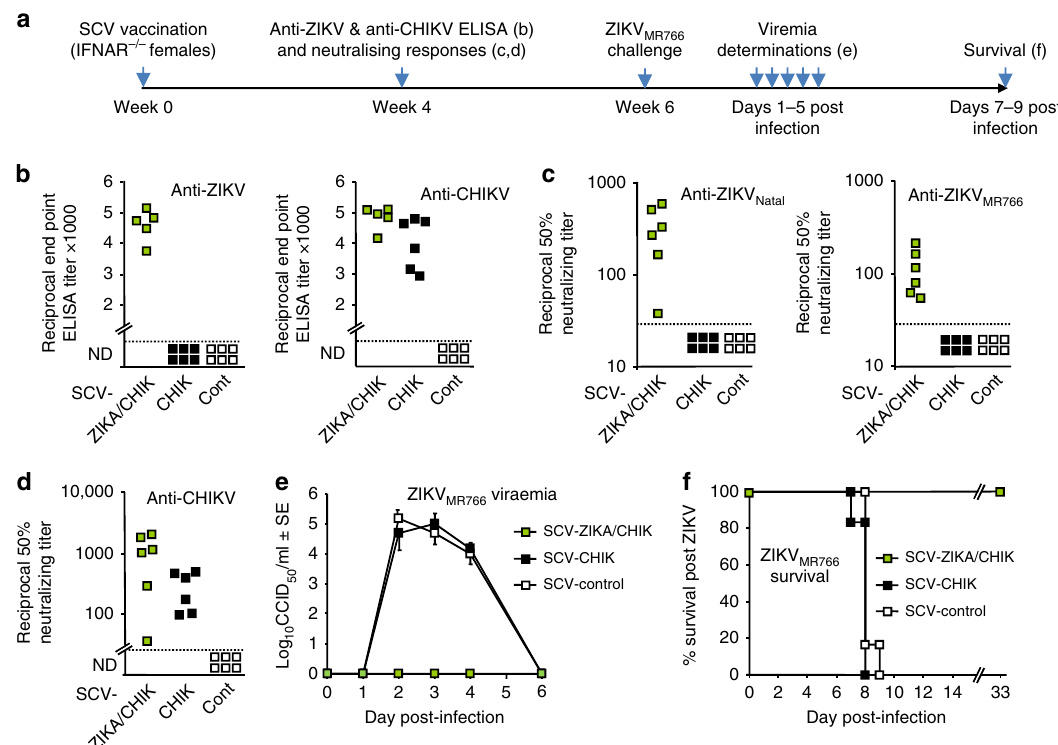
Fig. 3 ZIKV and CHIKV antibody responses in IFNAR − / − female mice and ZIKV MR766 challenge. a Timeline of vaccination, antibody assays, ZIKV challenge, viremia and survival determinations. b End point IgG ELISA titers against ZIKV and CHIKV 4 weeks post vaccination with 10 6 pfu of the indicated SCV vaccine. Limit of detection 1 in 30 dilution; ND not detected ( n = 5/6 mice per group). SCV-ZIKA/CHIK vaccinated mice had higher ZIKV and CHIKV titers than SCV-control vaccinated mice (all p = 0.009, Kolmogorov – Smirnov tests). (Differences in anti-CHIKV titers between SCV-CHIK and SCV-ZIKA/ CHIK were not signi fi cant). c Neutralization titers against ZIKV Natal and ZIKV MR766 in mice vaccinated with the indicated SCV vaccines ( n = 6 per group). (Verses SCV-cont, both p = 0.005, Kolmogorov – Smirnov tests). d Neutralization titers against CHIKV in mice vaccinated with the indicated SCV vaccines ( n = 6 per group). (Verses SCV-cont, both p = 0.005, Kolmogorov – Smirnov tests). (Differences in anti-CHIKV titers between SCV-CHIK and SCV-ZIKA/ CHIK were not signi fi cant). e Viremia after challenge with ZIKV MR766 (6 weeks post vaccination). Limit of detection 2 log 10 CCID 50 /ml. For days 2 – 4 the viremia in SCV-ZIKA/CHIK vaccinated mice ( n = 5/6 per group) was signi fi cantly lower than in SCV-control vaccinated mice (all p = 0.009, Kolmogorov – Smirnov tests). Error bars represent standard error of the mean. f Survival of mice described in e. Mice were euthanized when ethically de fi ned end points had been reached. SCV-ZIKA/CHIK vaccinated mice survived signi fi cantly longer than SCV-control vaccinated mice ( p = 0.001, log rank, Mantel – Cox, ZIKV models: (i) survival in IFNAR − / − mice infected with the mouse-adapted prototype African ZIKV MR766 strain of ZIKV, which is usually lethal in these GMO animals 27 ; (ii) fetal out- comes in IFNAR − / − dams infected with ZIKV Natal , an unpas- saged ZIKV isolate unequivocally associated with microcephaly 27 ; and (iii) testes infection and pathology in IFNAR − / − males infected with ZIKV Natal .